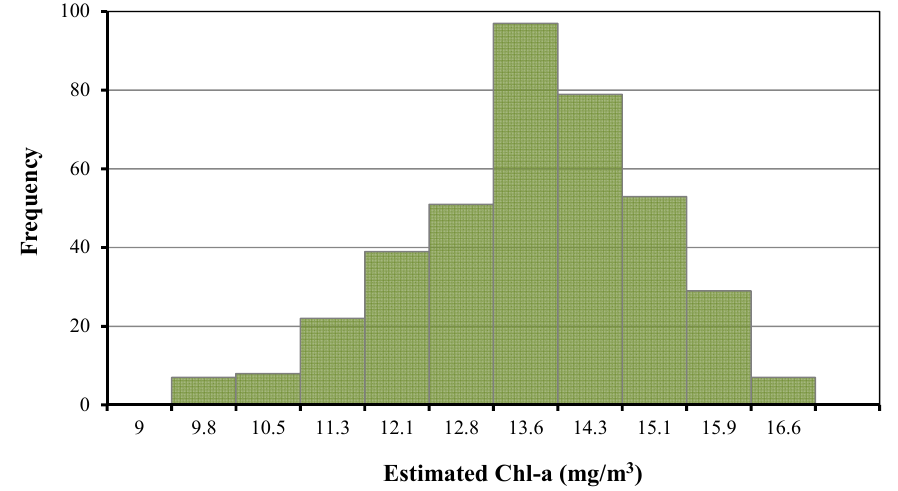
Figure 5. Histogram of Chl-a concentrations estimated from MODIS/Terra image data and